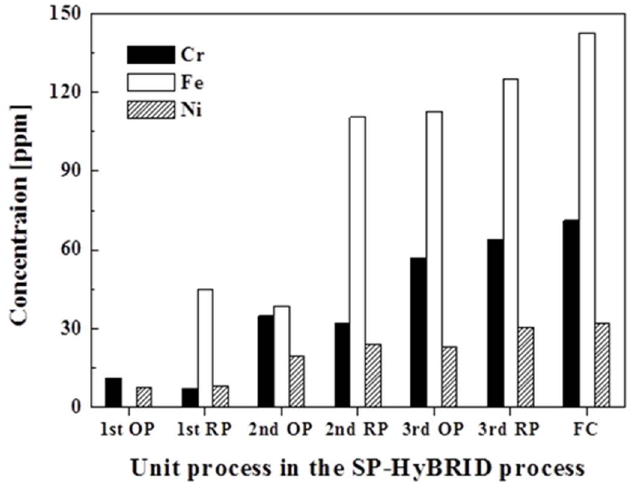
Figure 7. Concentrations of metal ions dissolved in each unit process solution during the mock-up test (OP: oxidative process, RP: reductive process, FC: filter cleaning).